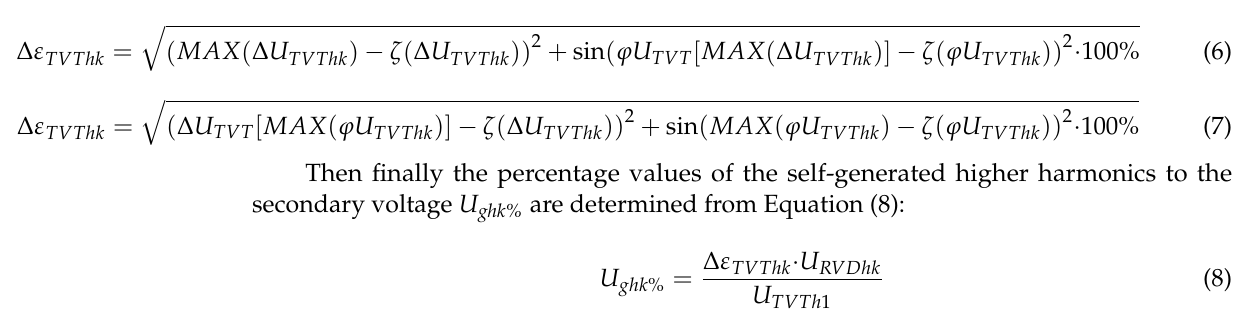
difference between the maximum value MAX( ∆ U TVThk ) and the average value ζ ( ∆ U TVThk ) of voltage error (Figure 7a: p. 3a) or the value of the difference between the maximum value MAX( ϕ U TVThk ) and the average value ζ ( ϕ U TVThk ) of phase displacement is calculated (Figure 7a: p. 3b). In the next step (Figure 7a: p. 4) the value of the composite error is calculated from Equation (6) for the maximum value of voltage error or from Equation (7) for the maximum value of phase displacement: